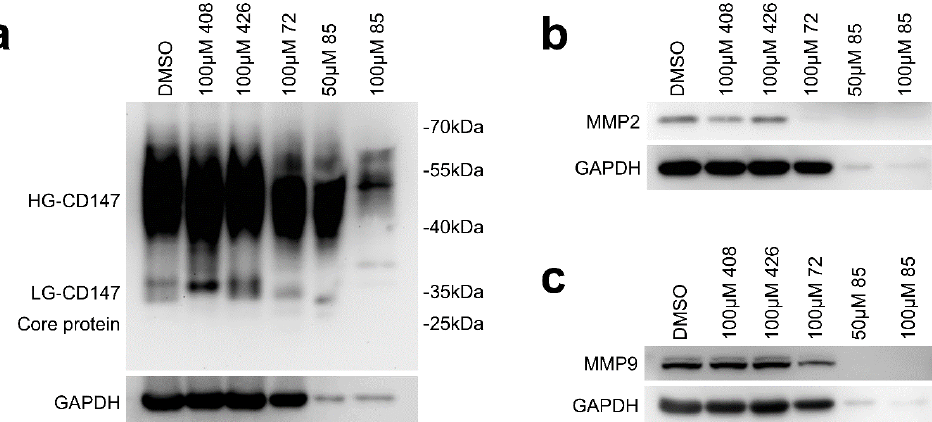
Figure 2. Four candidate inhibitorswere identified following docking studies and then Western blot analysis in Hela. ( a ) The effects of compounds 72 , 85 , 408 , and 426 on reducing of CD147 glycosylation for 24 h (compounds 72 and 85 for 12 h). ( b ) The effect of four compounds on matrix metalloproteinase (MMP2) expression and ( c ) MMP9 expression for 24 h (compounds 72 and 85 for 12 h).